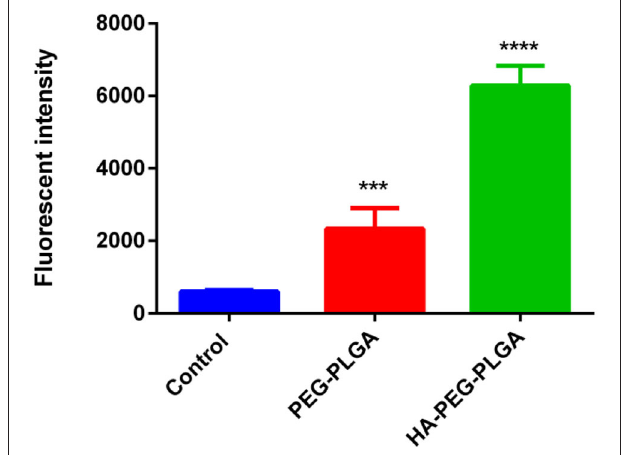
FIGURE 1 | In vitro release profiles of Cur and Sal from HA-PEG-PLGA-Cur-Sal nanoparticles in sodium phosphate buffer at pH 5.0 and pH 7.4 at 37 ◦ C, respectively. Error bars show mean ± standard deviation from experiments performed in triplicate.